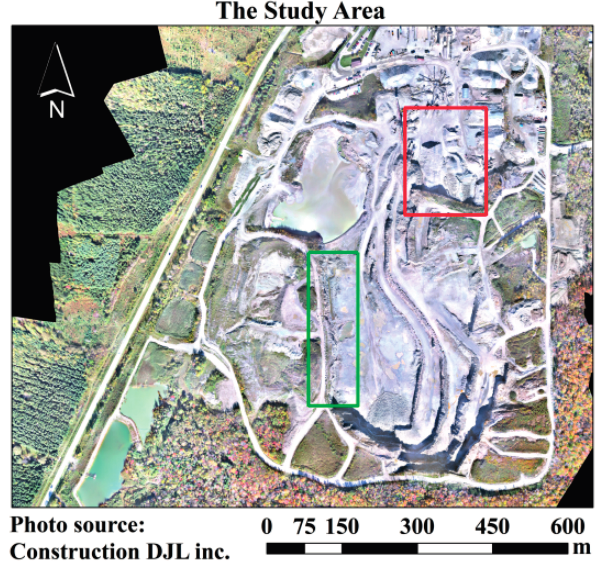
Figure 5. The study area and mapping